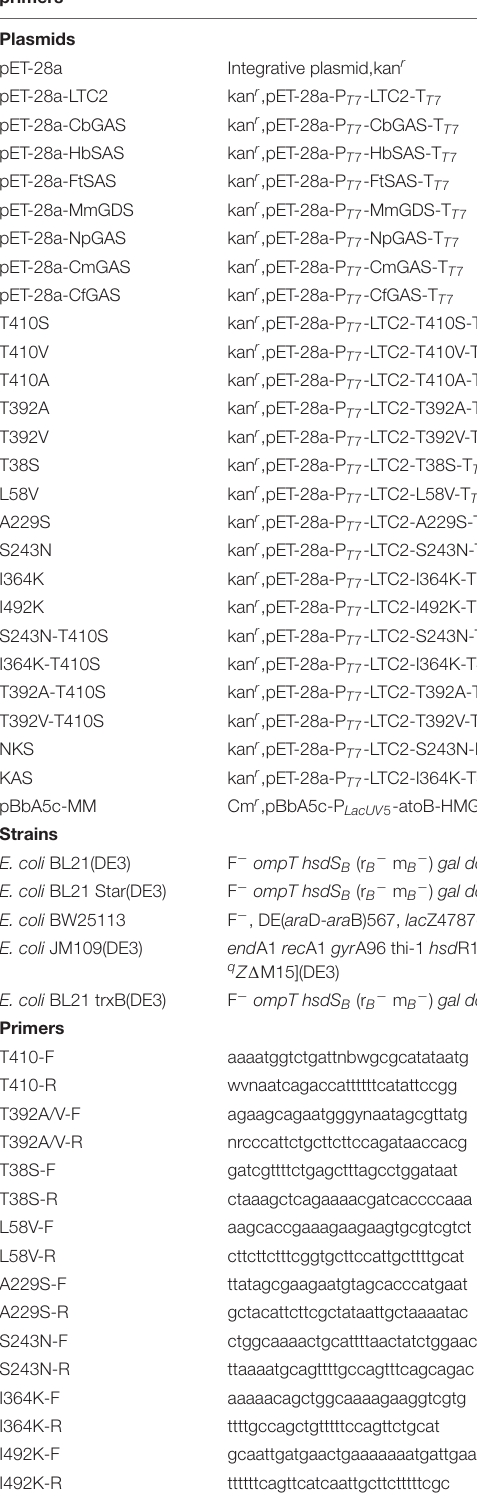
TABLE 1 | Plasmids, strains, and primers used in this study. Plasmids, strains and primers